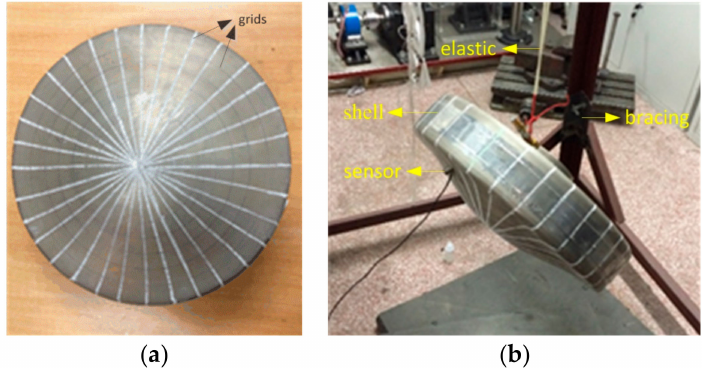
Figure 2. The modal test of a moment wheel assembly’s (MWA’s) shell: ( a ) an MWA shell with grid; ( b ) modal test of an MWA.